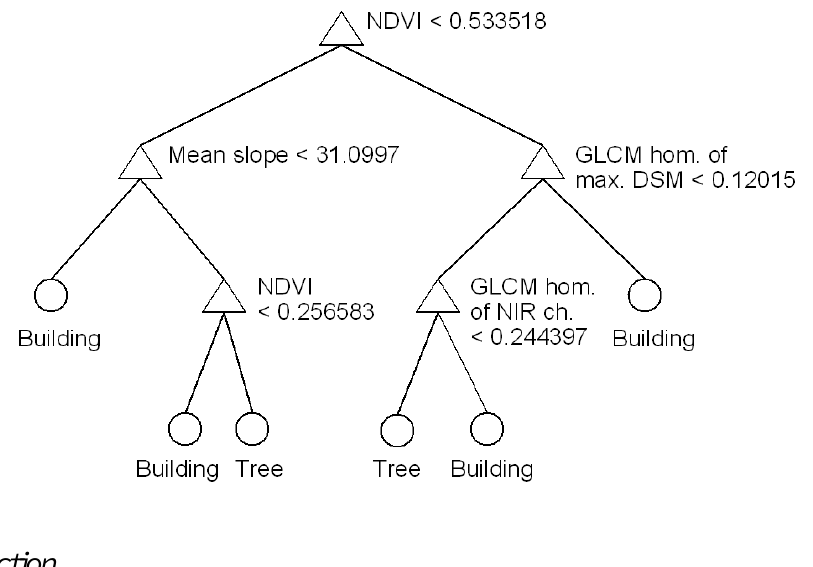
Figure 2. Classification tree used in the building detection tests. GLCM hom. of max. DSM is GLCM homogeneity calculated from the maximum DSM, and GLCM hom. of NIR ch. is GLCM homogeneity calculated from the near-infrared channel of the aerial